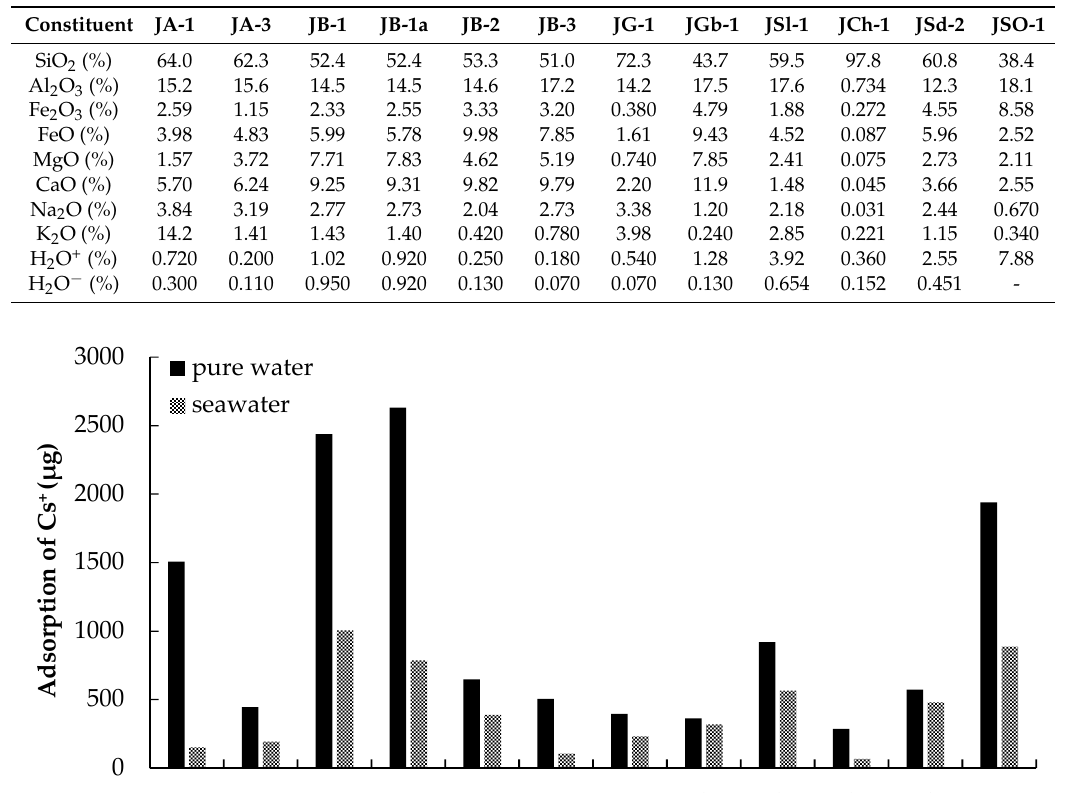
Table 1. The major constituent of natural Japanese rocks.